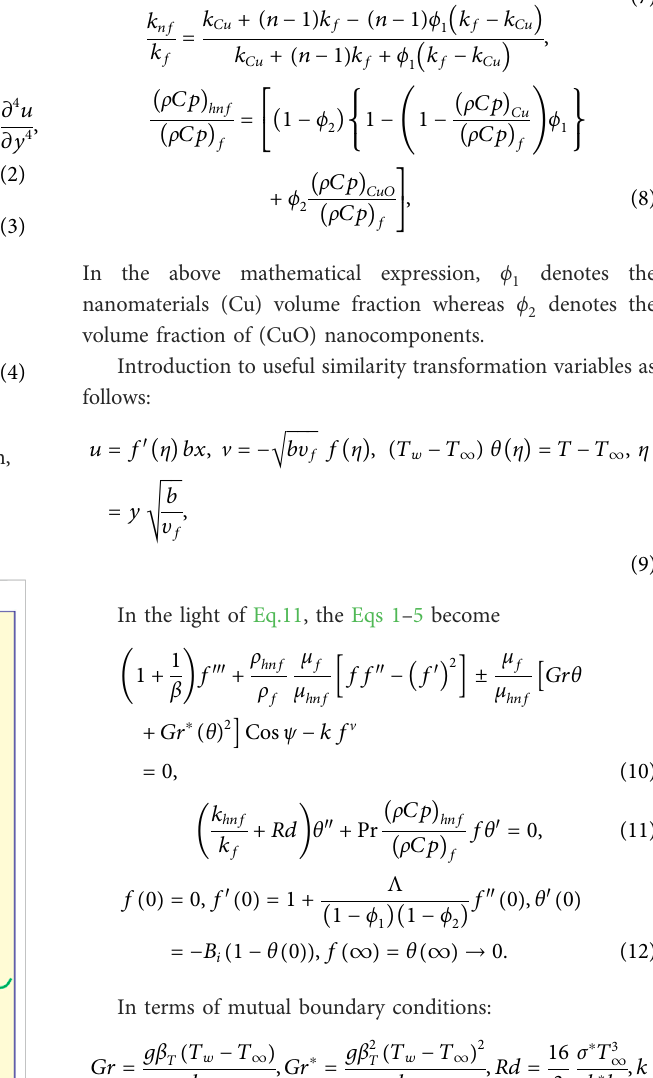
FIGURE 1 The solar collector absorbing